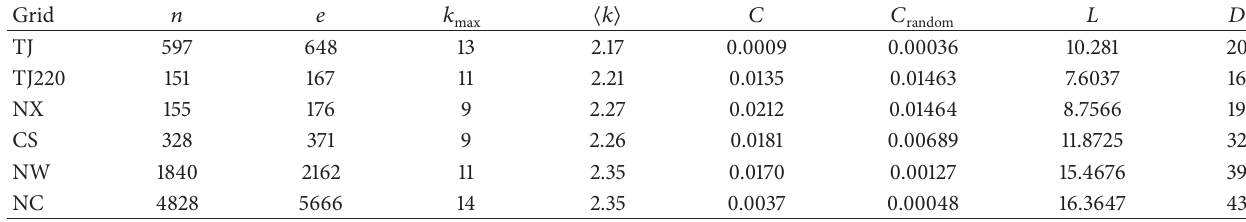
Table 1: Statistical characteristic parameter values of power grids.